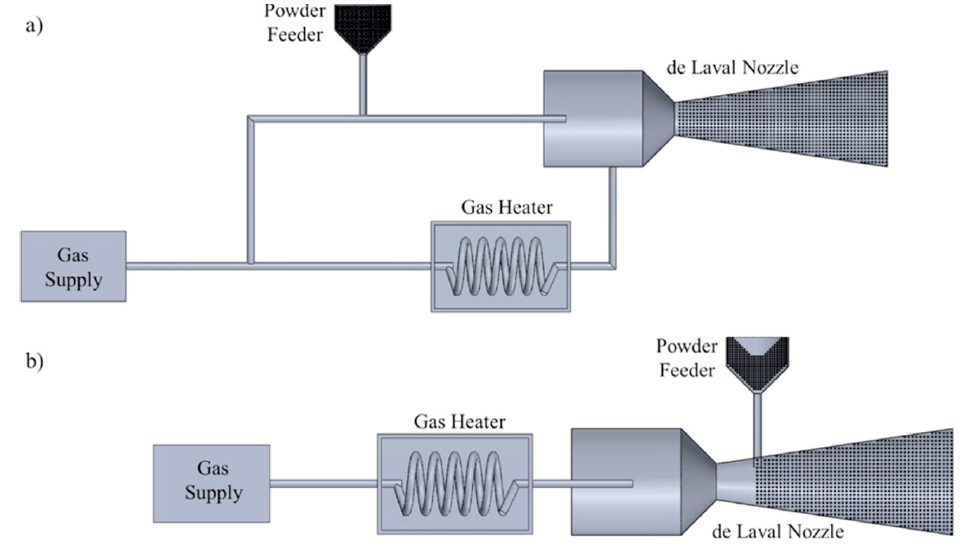
Figure 4. Schematic diagram showing typical cold spray system showing ( a ) high-pressure and ( b ) low-pressure systems. Reprinted with permission from Ref. [3]. Copyright 2022, Elsevier.